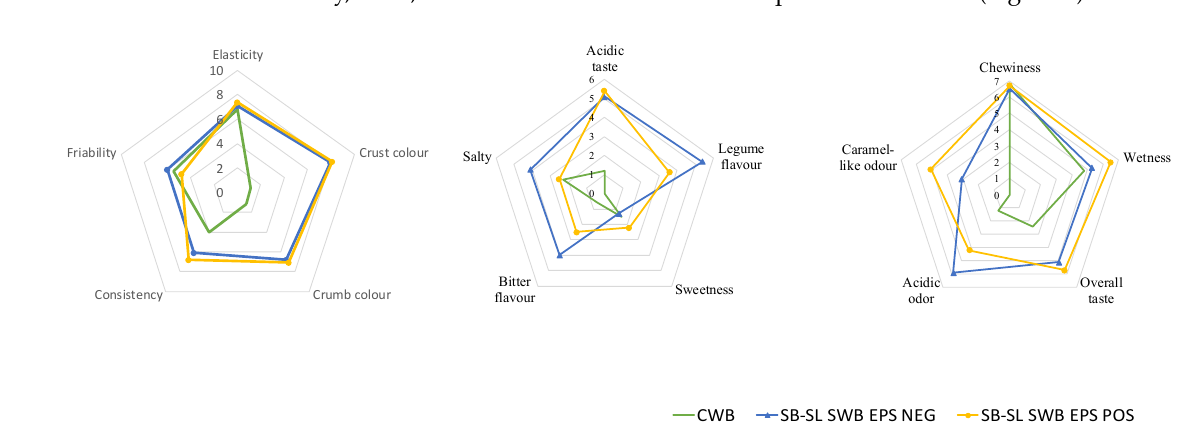
Figure 4. Spider web chart of the sensory analysis data for control and sourdough breads (DY 162). CWB, control wheat bread started with baker’s yeast; SB-SL SWB EPS NEG, bread containing wheat flour added with 30% ( w / w ) sprouted barley–sprouted lentil (30:70% w / w ) sourdough fermented by Leuconostoc pseudomesenteroides DSM 20193; SB-SL SWB EPS POS, bread containing wheat flour added to 30% ( w / w ) dextran-containing sprouted barley–sprouted lentil (30:70% w / w ) sourdough fermented by L. pseudomesenteroides DSM 20193. The initial cell density of the strain was ca. 7 log cfu/g. The sourdough was fermented at 20 °C for 24 h.